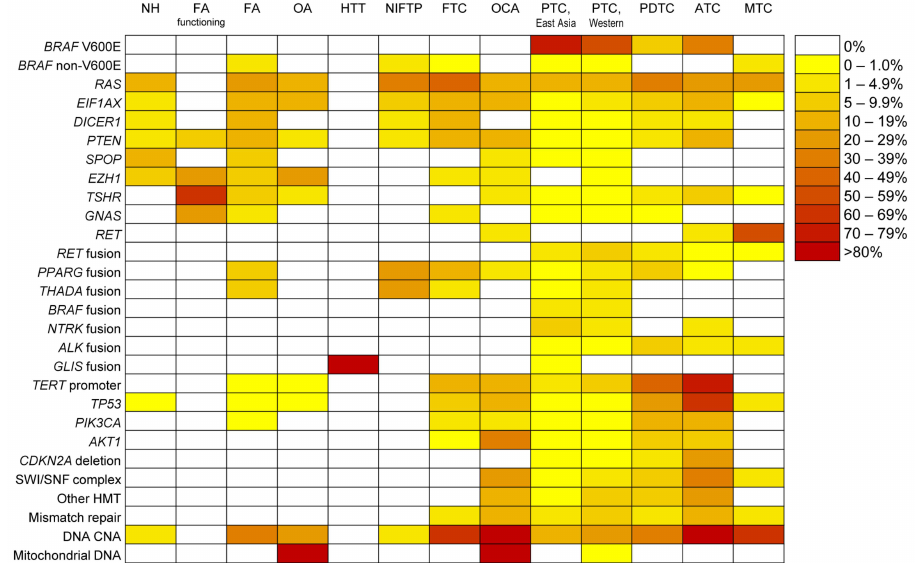
Figure 1. Frequency and pattern of genetic alterations across thyroid tumors. The heatmap depicts the frequency of non-synonymous mutations, deletions and fusions in selected genes, and copy number alterations (CNA). NH, nodular hyperplasia; FA, follicular adenoma; OA, oncocytic adenoma;